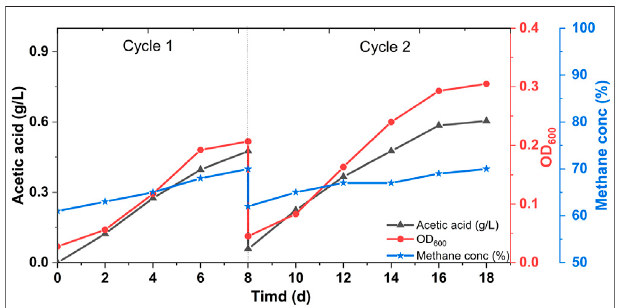
FIGURE 1 | Microbial growth (in terms of OD 600 ), acetic acid and methane concentration pro fi les of the MES reactors fed with biogas in batch mode